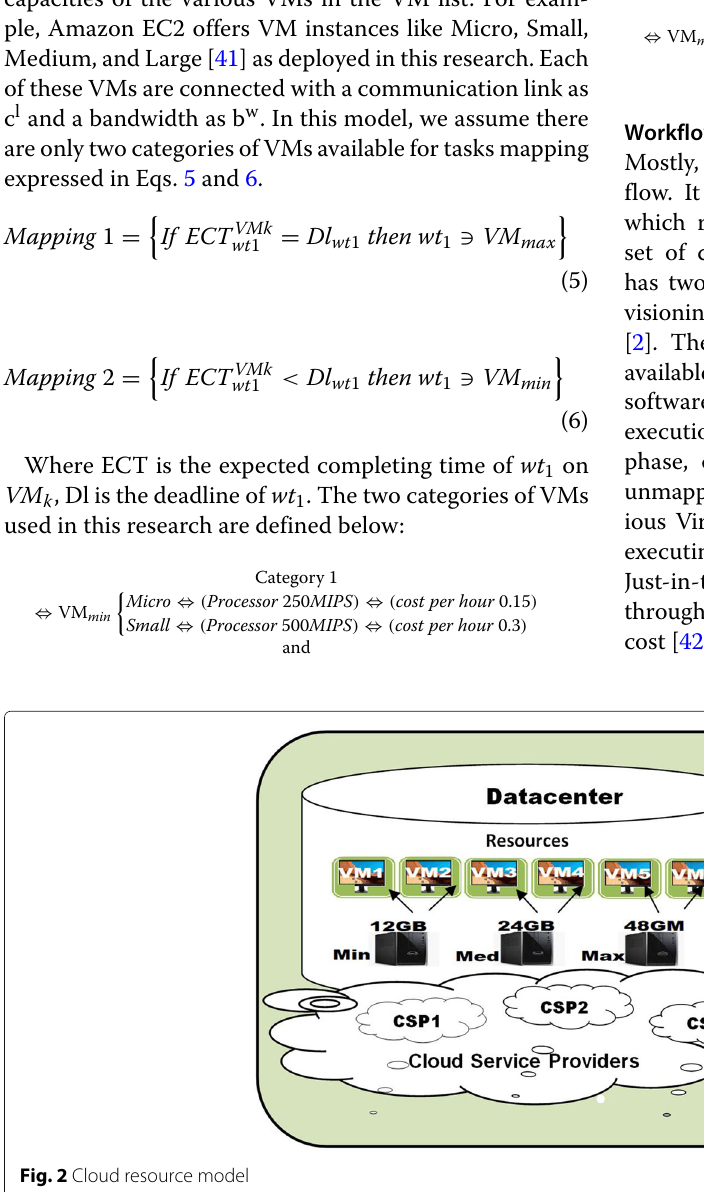
capacities of the various VMs in the VM list. For exam- ple, Amazon EC2 offers VM instances like Micro, Small, Medium, and Large [41] as deployed in this research. Each of these VMs are connected with a communication link as c l and a bandwidth as b w . In this model, we assume there are only two categories of VMs available for tasks mapping expressed in Eqs. 5 and 6.